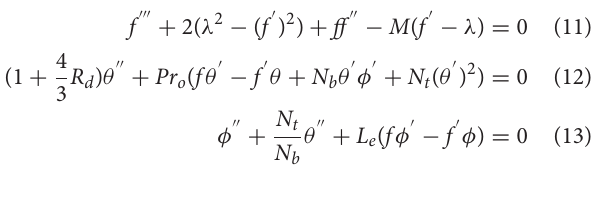
TABLE 1 | ( For Case A ) Comparison of